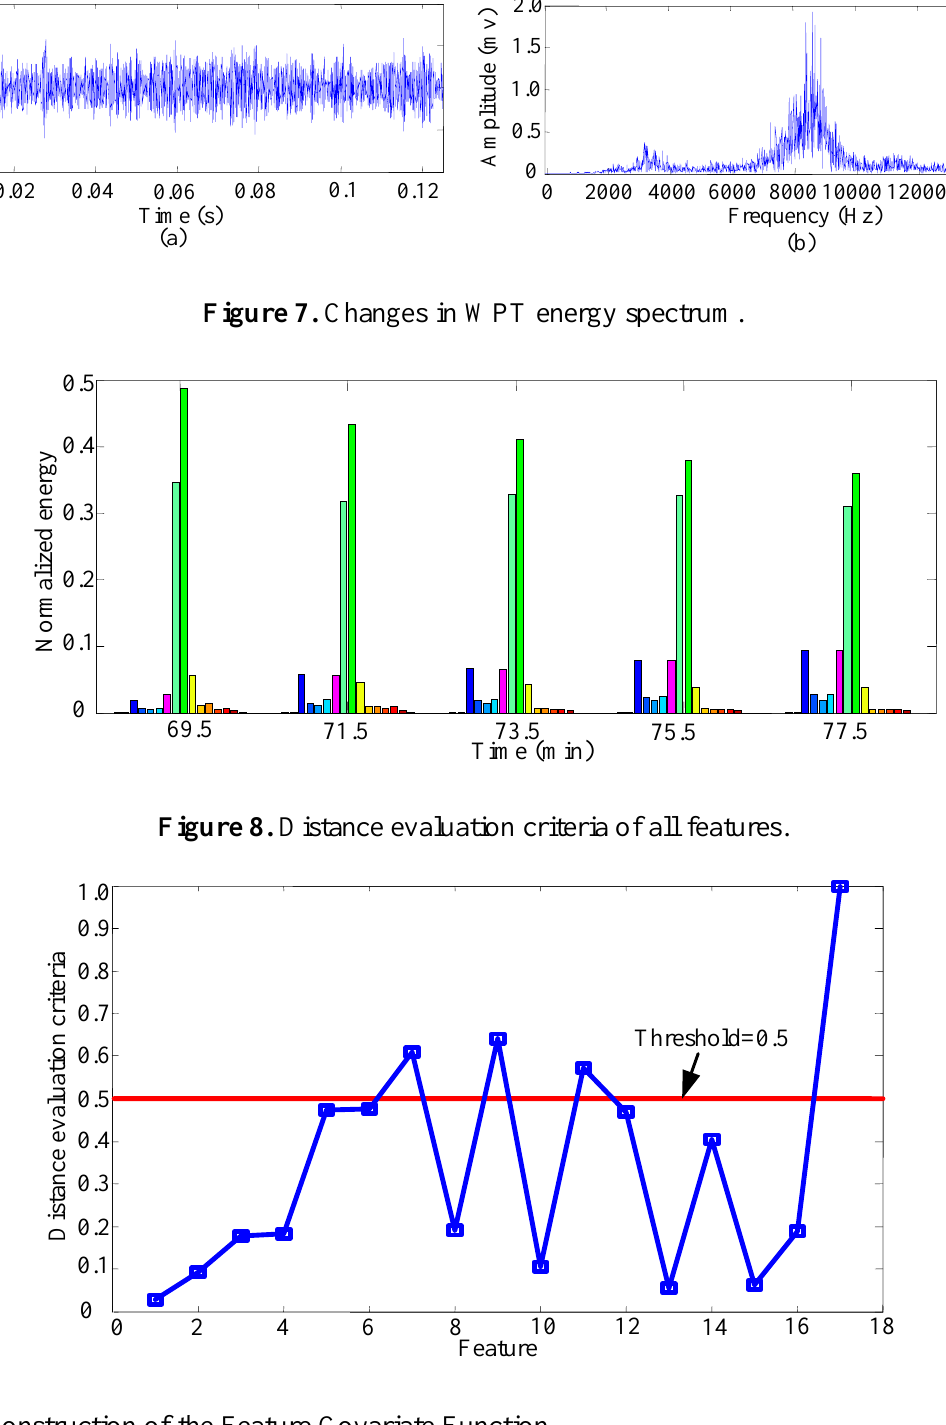
Figure 6. ( a ) Vibration signal and ( b ) spectrum of tool No. 3 after running for 69.5 min.